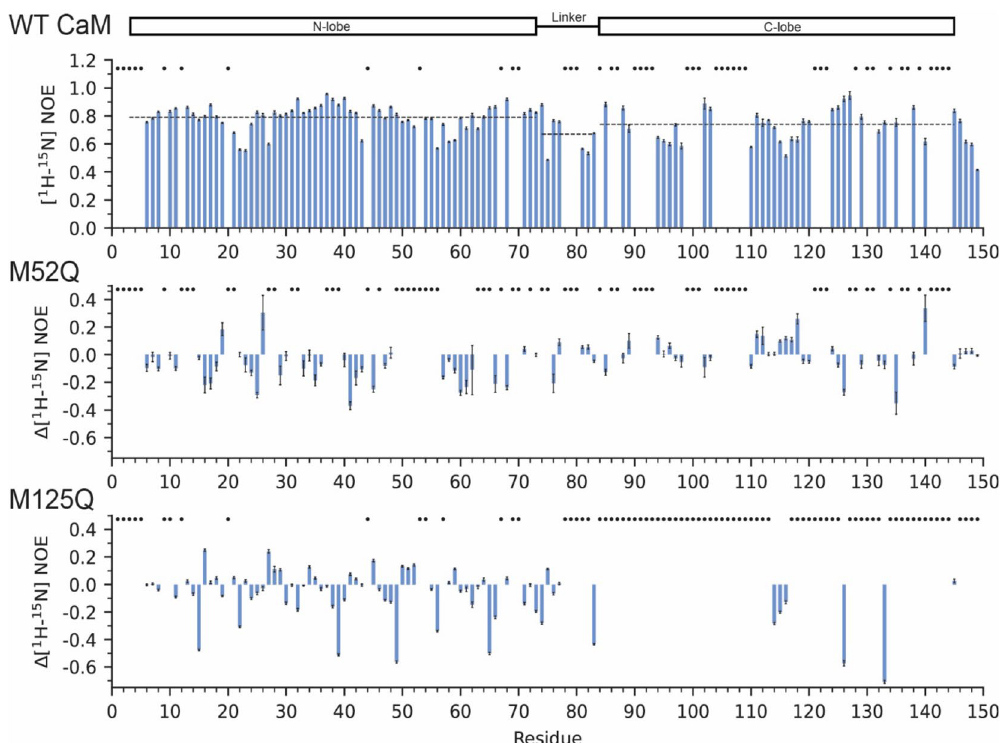
Figure 3. [ 1 H, 15 N] Backbone NOE values in the absence of Ca 2+ . [ 1 H, 15 N] backbone heteronuclear NOE values for WT-CaM in the absence of Ca 2+ (top). Relative differences in NOEs for Ca 2+ -free M52Q-CaM , and M125Q- CaM are shown in the lower panels. NOE values for each residue were determined using the ratio between the peak intensities of the saturated and unsaturated spectra. Error bars represent the uncertainty in each NOE value, determined relative to the baseline noise level in the saturated and unsaturated spectra. Dashed lines indicate the average NOE of each domain. NMR Spectra were analyzed using NMRFAM-Sparky 46